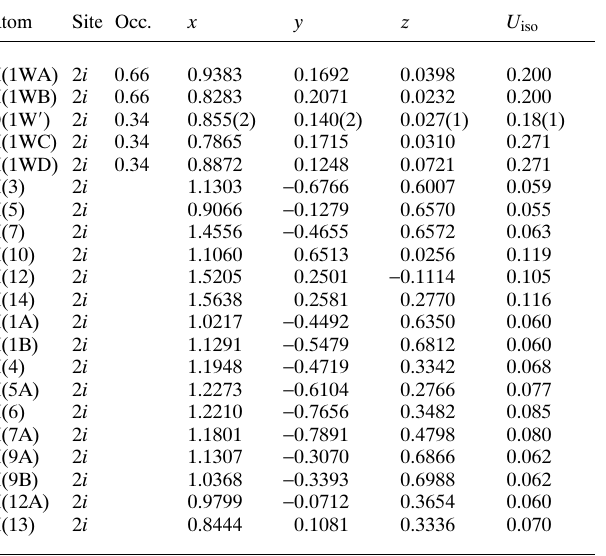
Table 2. Atomic coordinates and displacement parameters (in Å 2 ) .